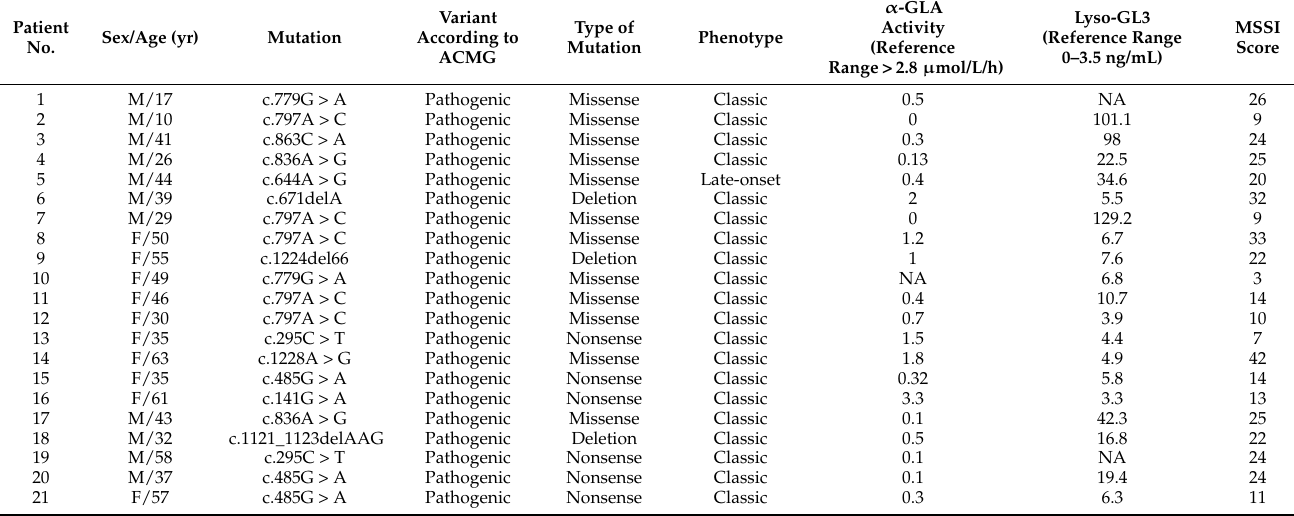
Table 3. Genotype, baseline level of α -GLA activity and lyso-GL3, as well as MISSI score of the study